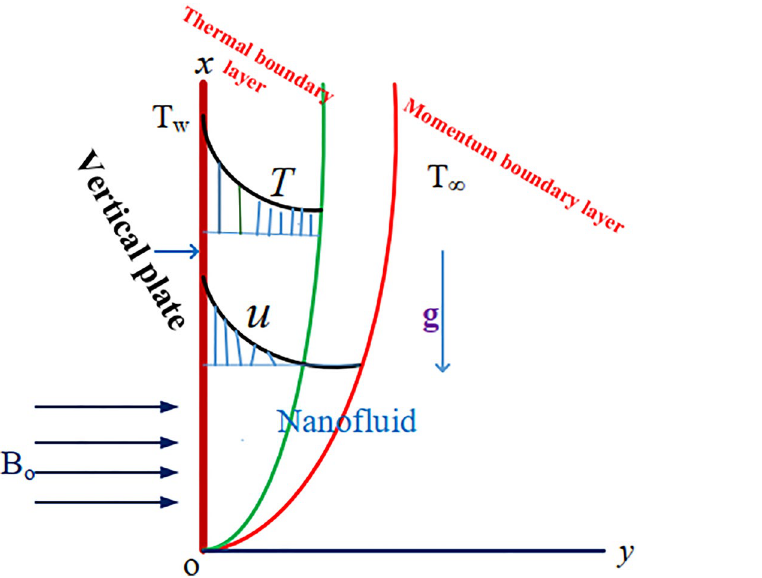
Figure 1. Geometrical flow of the